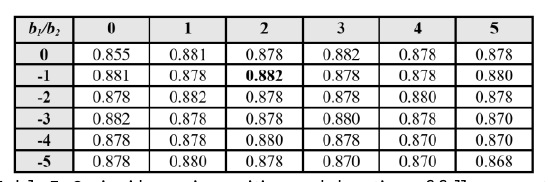
Table 5. Coincidence in position and duration of fall segments determined by the procedure and labeled by experts